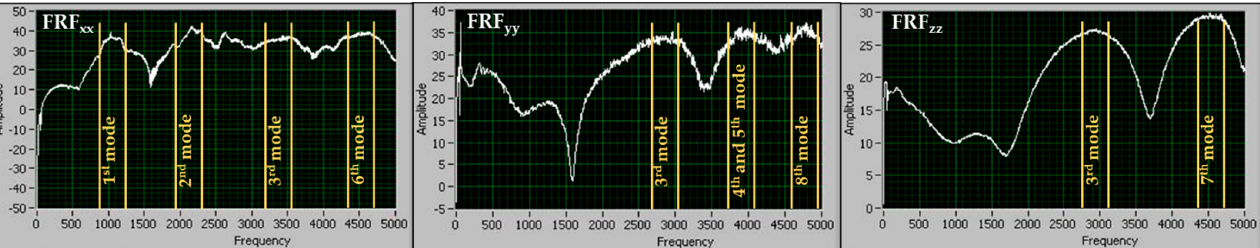
Figure 4. Experimentally obtained frequency response functions [7].